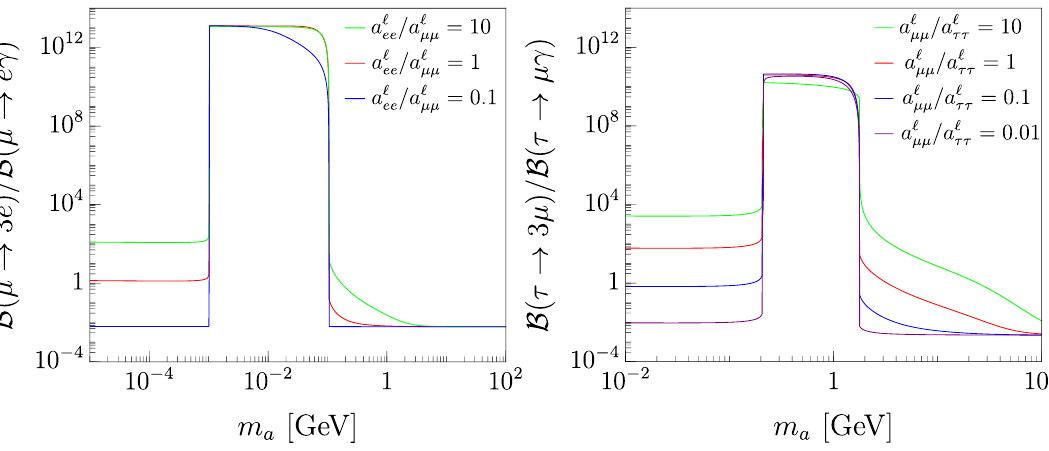
Figure 5 . ratios a ‘ the text for more